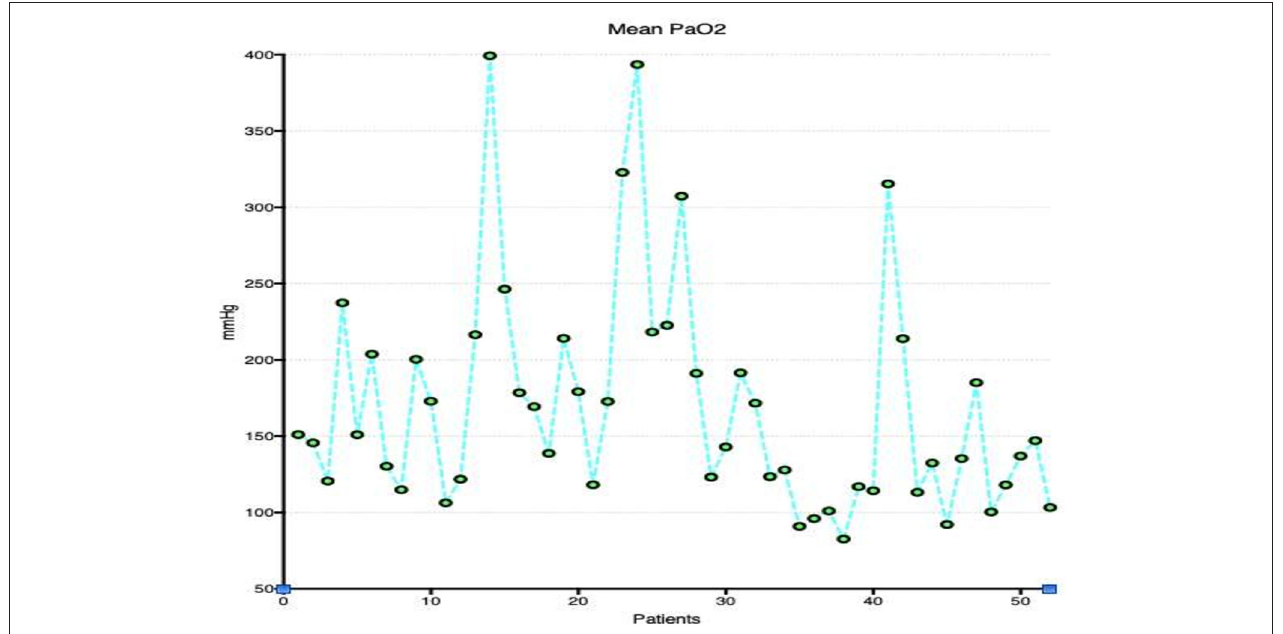
FIGURE 3 | Mean PaO 2 for individual patients during their entire duration of ECMO